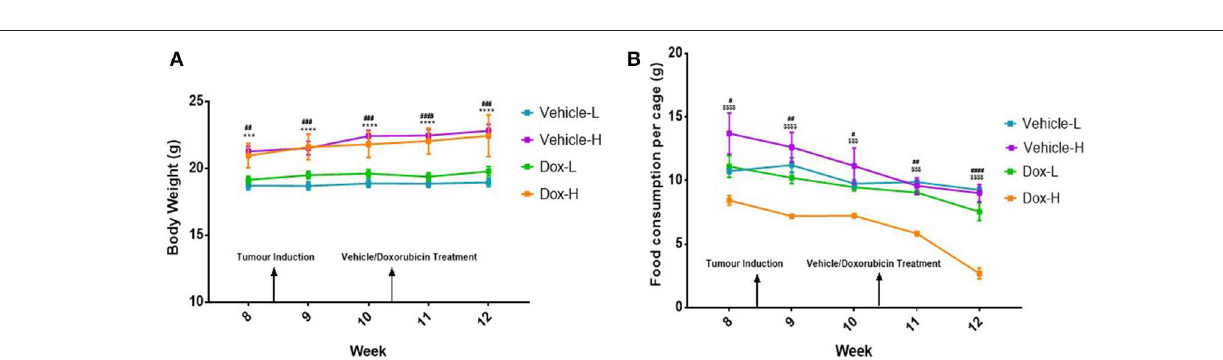
Frontiers in Oncology |